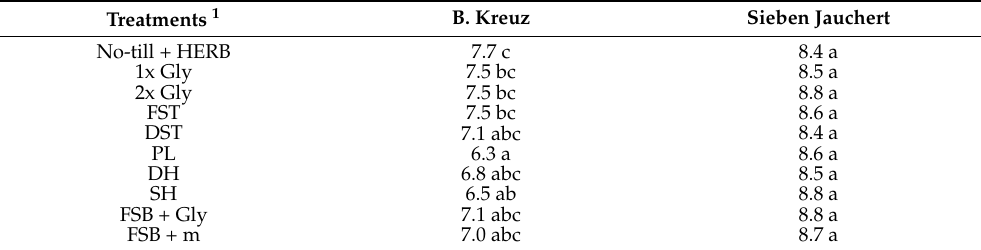
Table 8. Winter wheat grain yield (Mg ha − 1 ) in 2020 at B. Kreuz and Sieben Jauchert. Levels of significance are shown behind the result for each experiment site separately. Means with the same letter are not significantly different according to HSD test at p ≤ 0.05. Levels of significance are shown behind the result for each experiment site